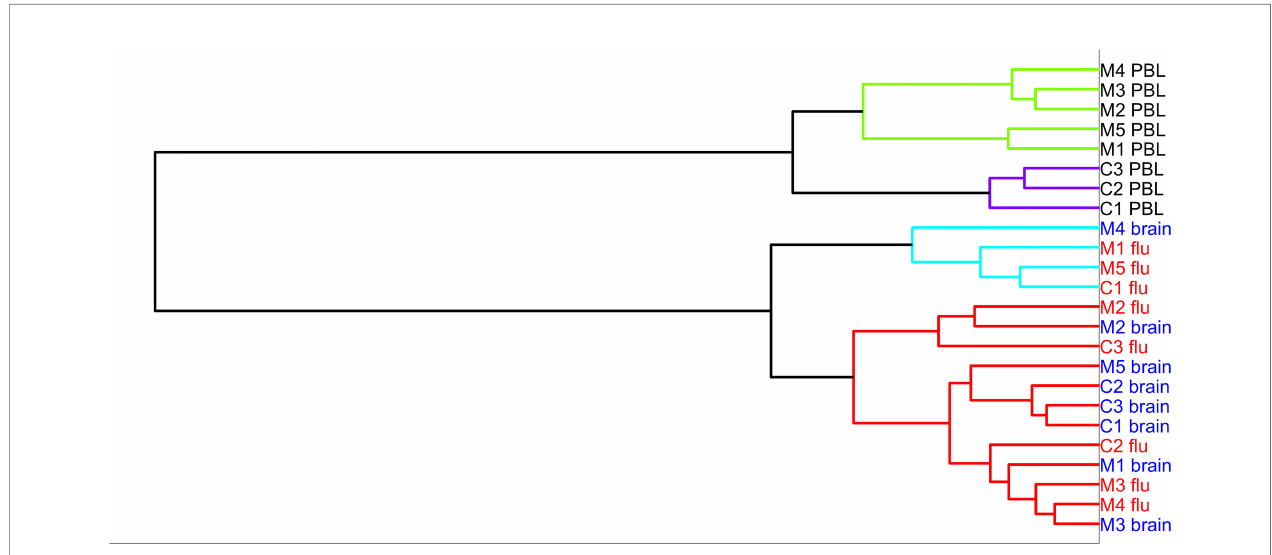
FIGURE 2 | Hierarchical clustering of the fi ve MS samples (MS) — brain-stimulated, fl u-stimulated, and unstimulated, and three controls (C) — brain-stimulated, fl u- stimulated, and unstimulated over the entire set of